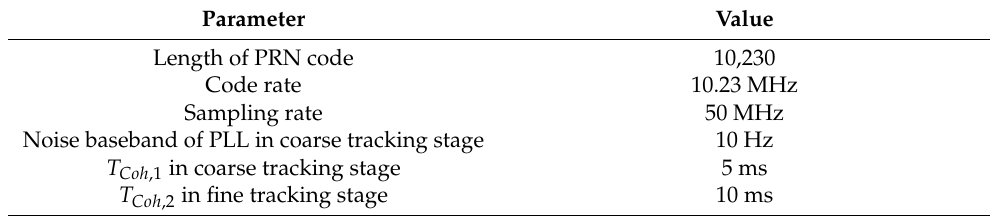
Table 1. Simulation